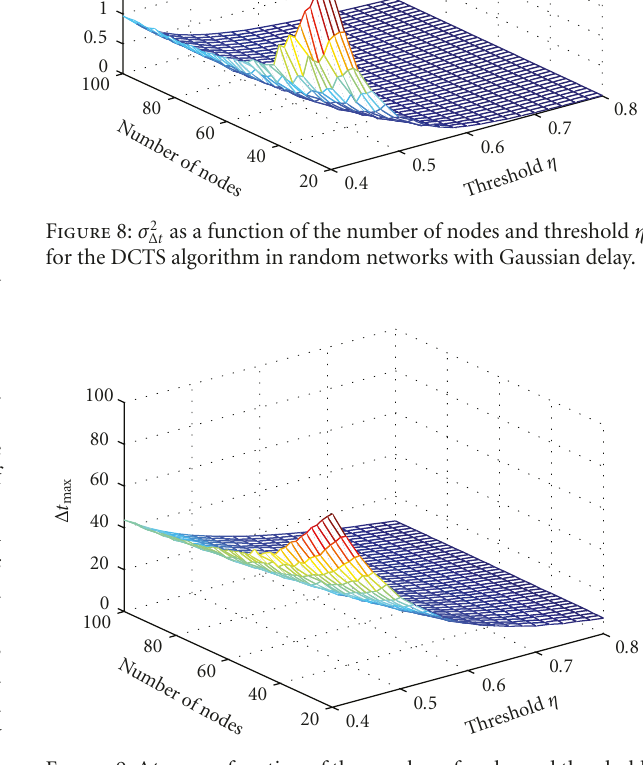
Figure 9: Δ t max as a function of the number of nodes and threshold η for the DCTS algorithm in random networks with Gaussian